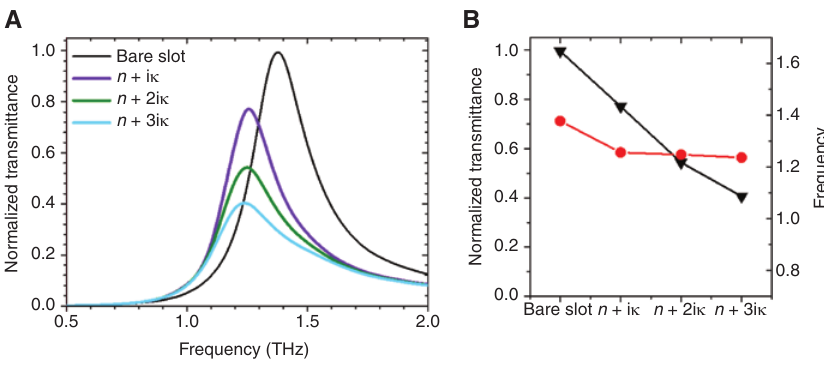
Figure 25: Light transmission with varying imaginary part of the refractive index of the clad. (A) Normalized transmittance to the incidence was simulated for various complex refractive indices. (B) The peak of the transmittance value and the resonance frequency were plotted in terms of the refractive